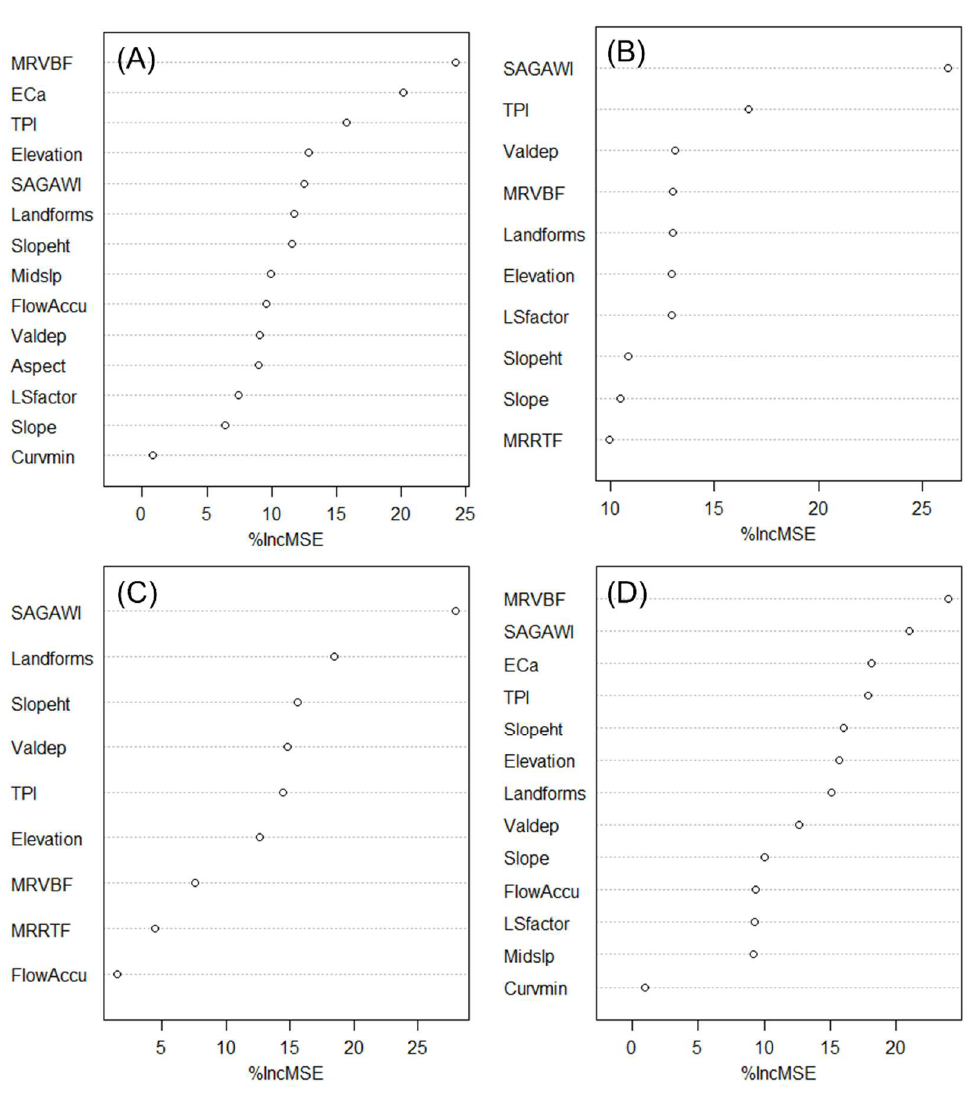
Figure 4. Variable importance in predicting soil health indicators (( A ) one-day CO 2 ; ( B ) organic C; ( C ) organic N) and ( D ) soil health index in the study area (%IncMSE: percent increase in the mean square error of prediction) .